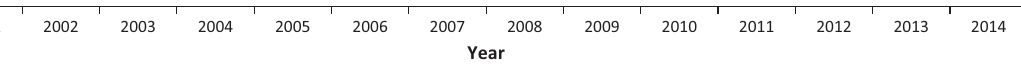
FIGURE 1: South Africa’s Value of imports and exports to the EU